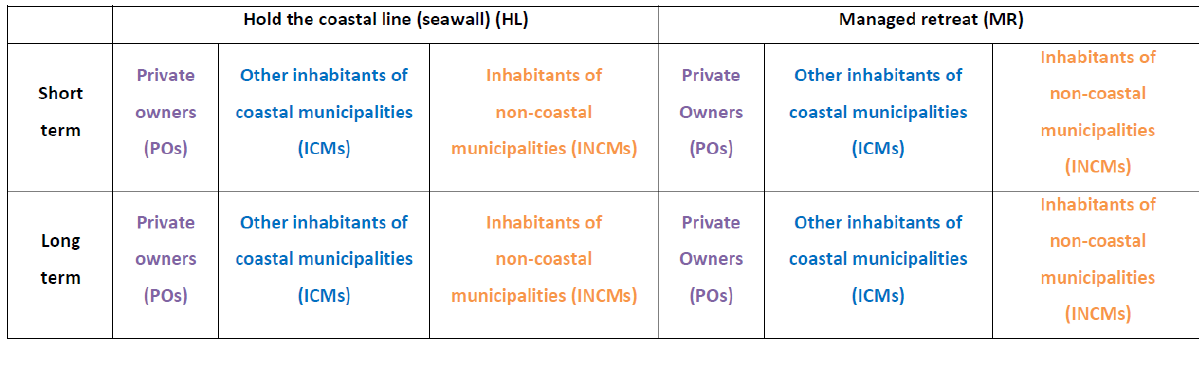
Table 2. Indicators of environmental inequalities and their definition.